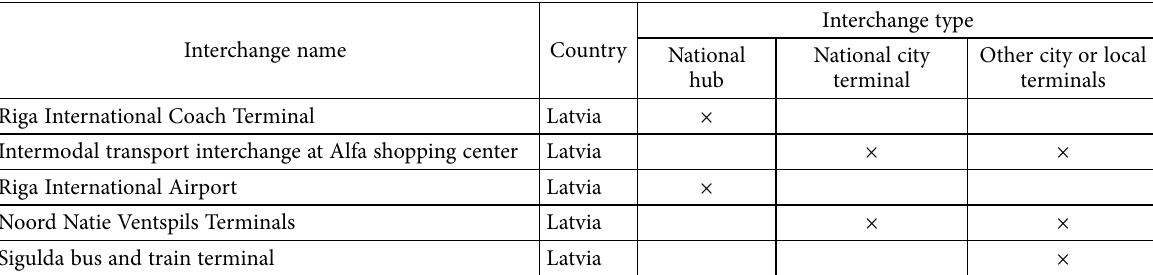
Table 2. Overview of passenger interchanges in Latvia